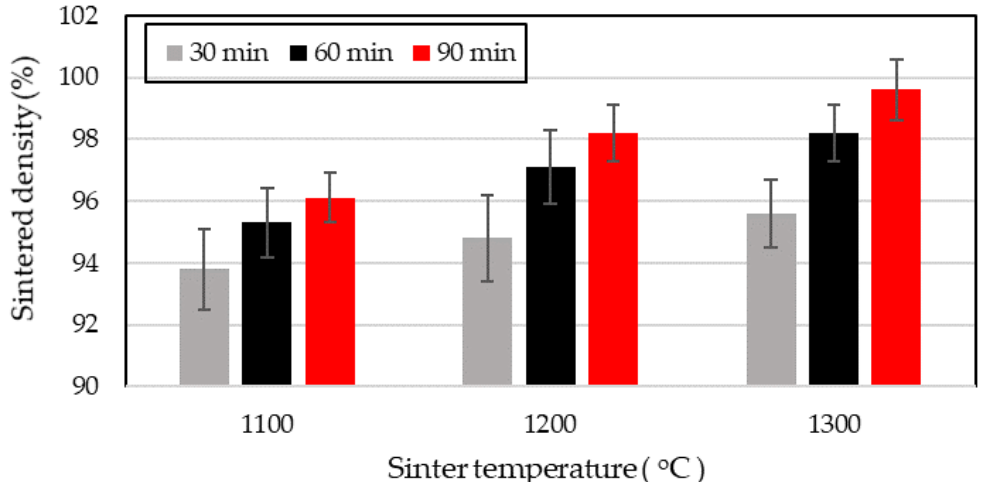
Figure 8. Sintered density of the titanium strips.